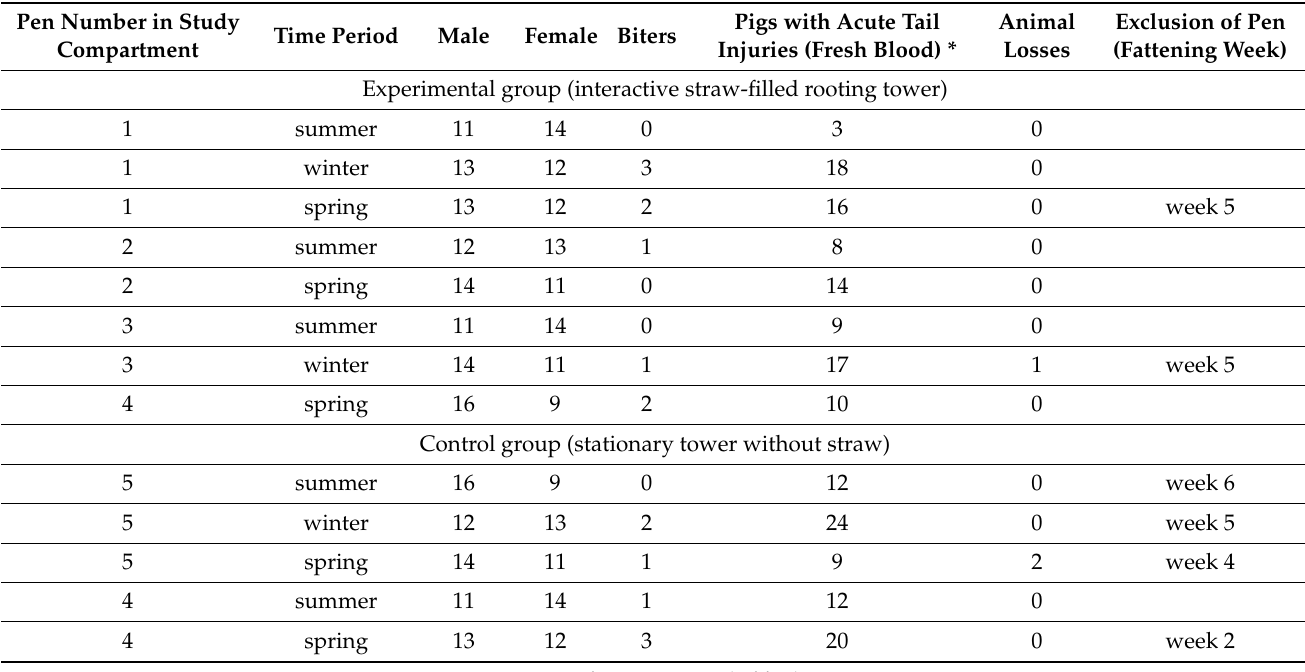
Table 1. Summary of animals in pens allocated to groups (experimental and control) and fattening periods (batch/season) in the